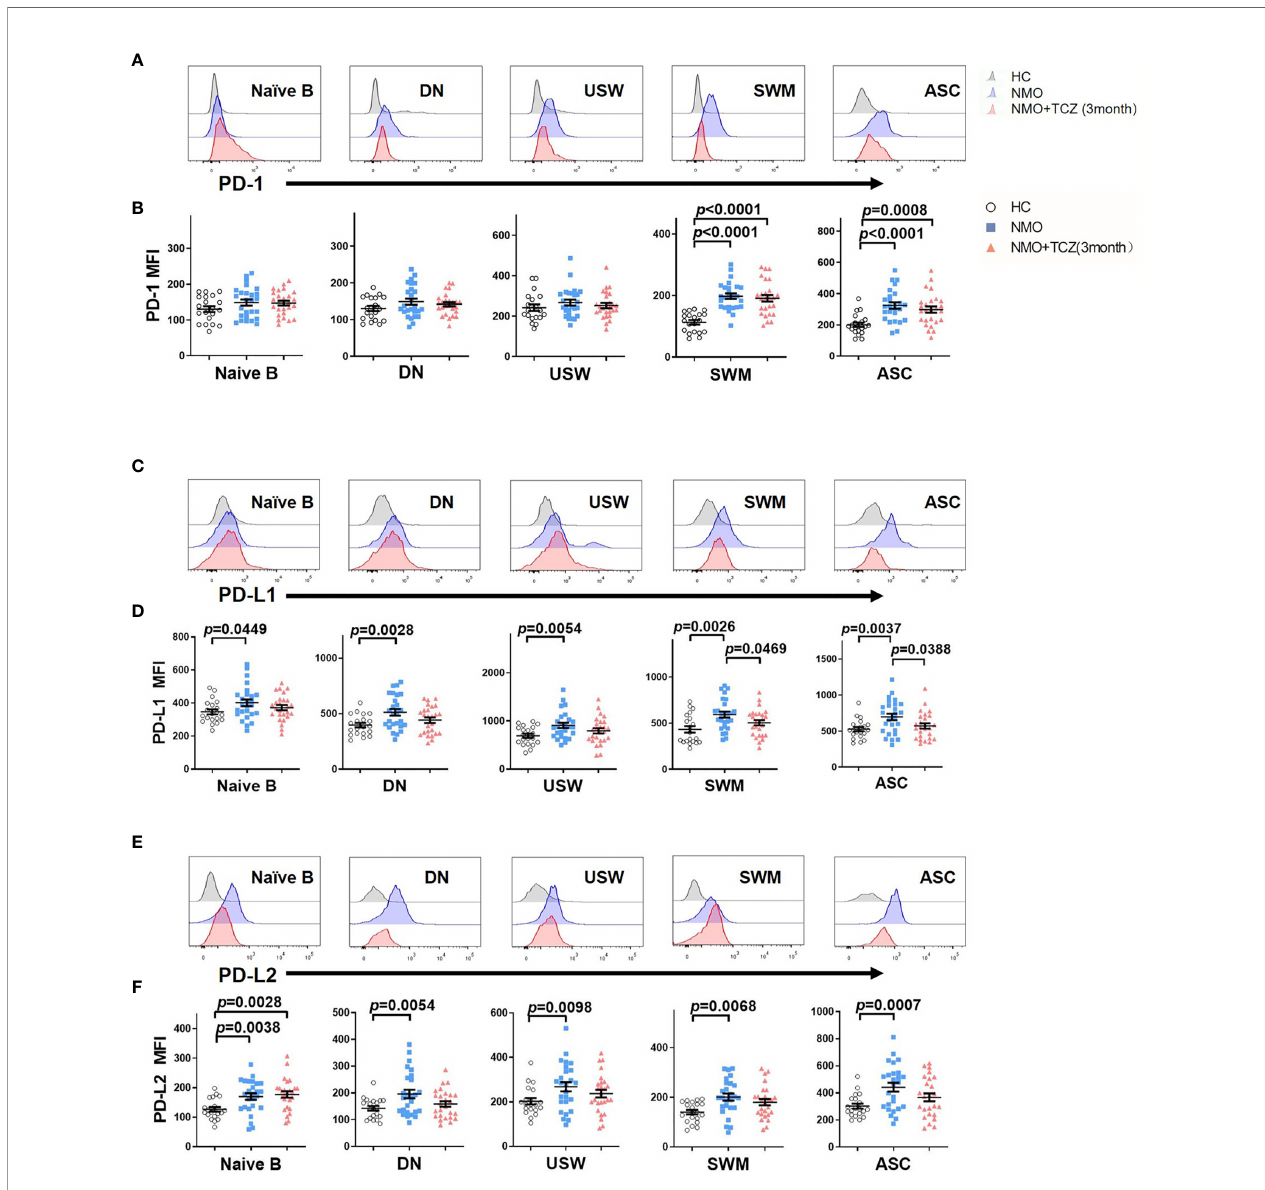
FIGURE 6 | The expression of PD-1 and its corresponding ligands PD-L1 and PD-L2 on B cells subsets from healthy control (HC) and NMOSD patients before and after treatment. (A, C, E) Representative histograms of PD-1, PD-L1, PD-L2 in several B cells subsets from a healthy control and NMOSD patients before and after treatment. (B, D, F) was the quantitative analysis of mean fl uorescence intensity (MFI) of PD-1, PD-L1&PD-L2 in several B cells subsets. Unpaired, two-tailed Student ’ s t tests (if the distribution is normal) or Mann-Whitney U tests (if it does not conform to the normal distribution) were used,